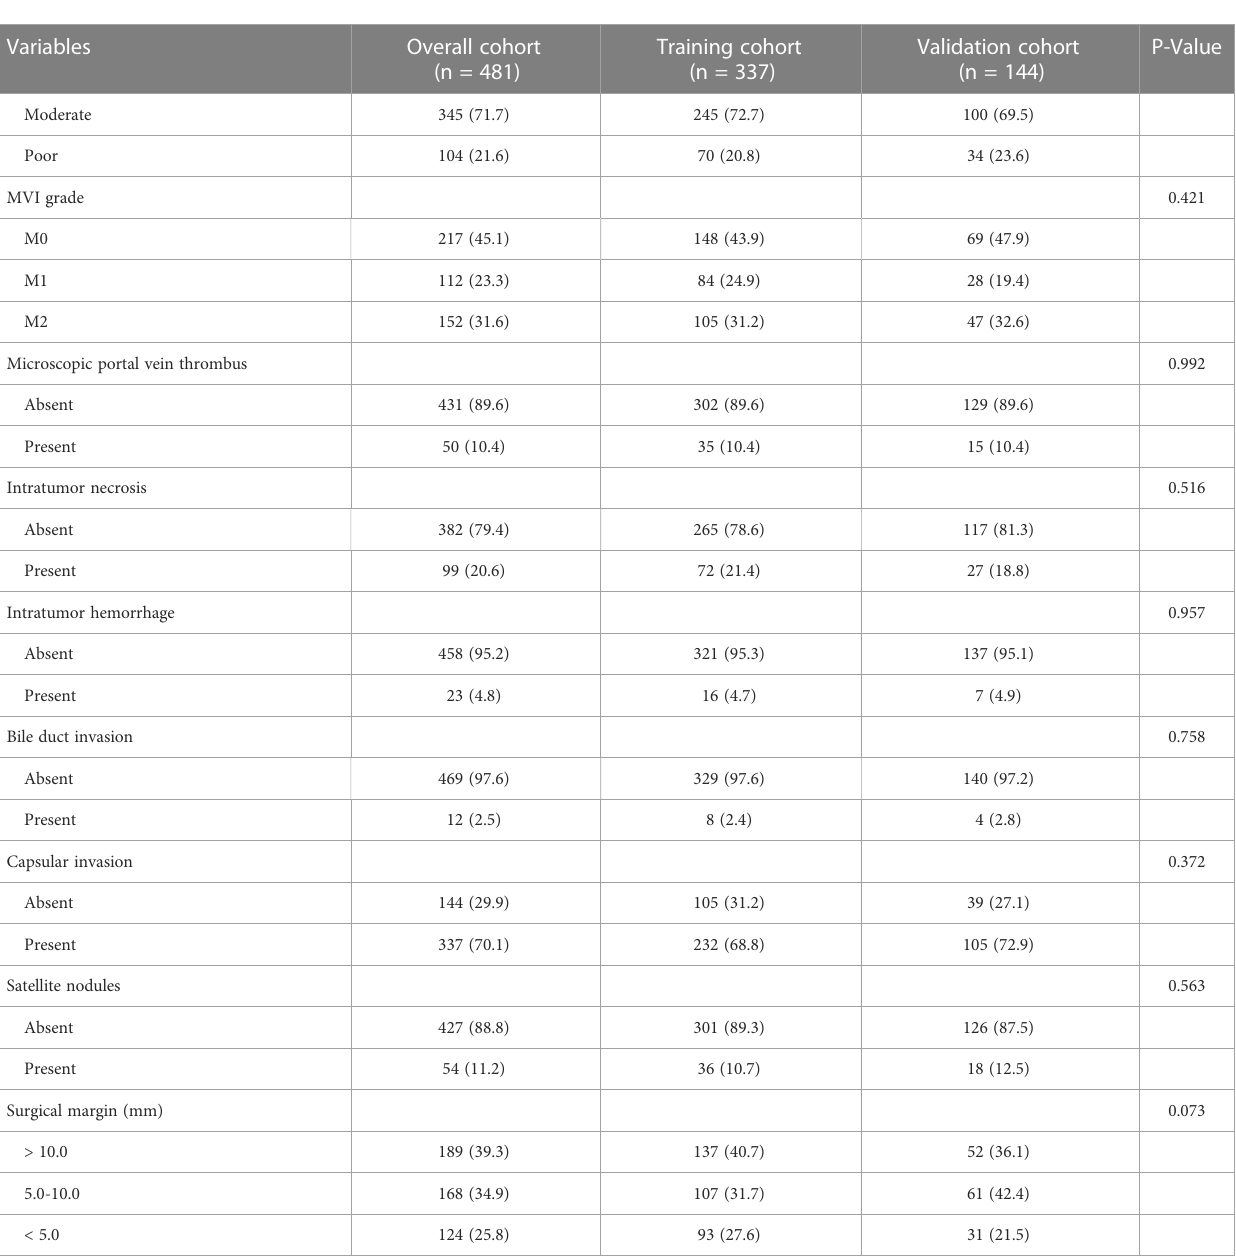
A Forest plot was drawn to show the effect of different risk factors on patient RFS (Figure 4). M2 subgroup of MVI had the strongest predictive power for early recurrence (HR: 3.120; 95%CI: 1.977-4.925).